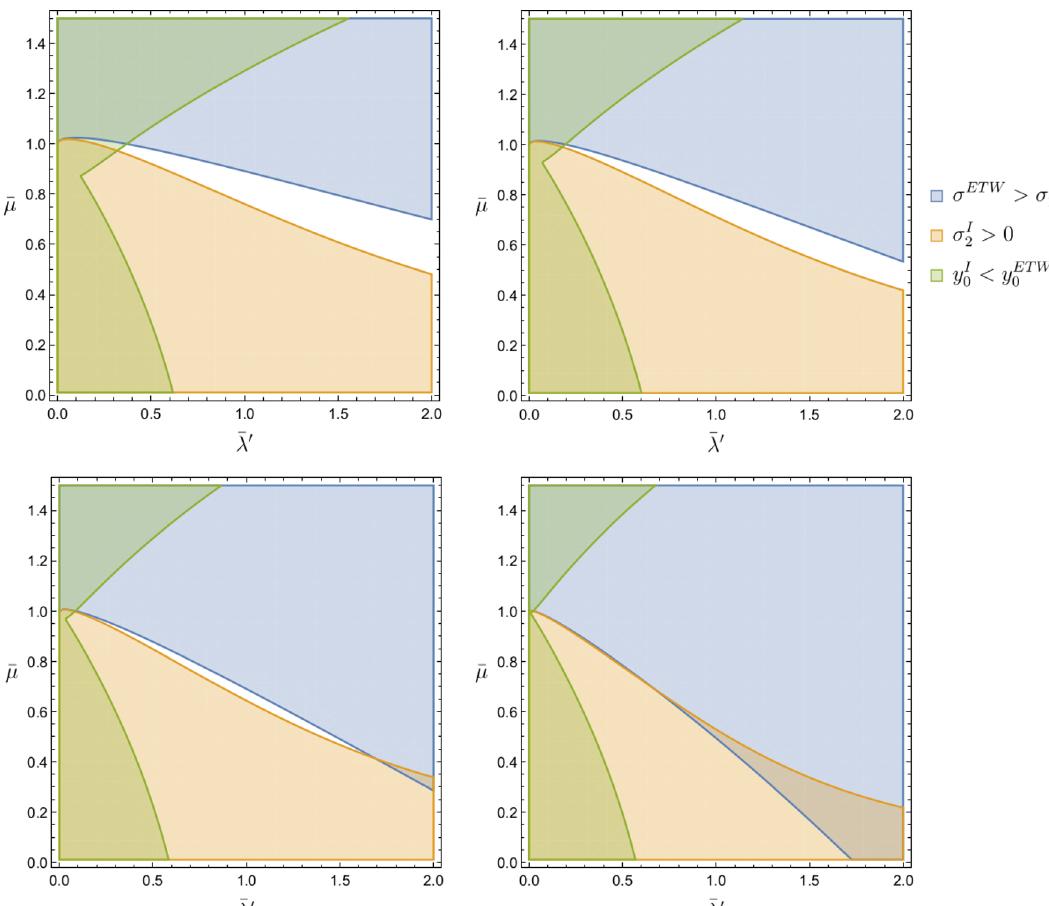
Figure 5 . Plots of the regions in the parameter space (¯ λ 0 , ¯ µ ) with σ ETW > σ I with d = 4 , ¯ T = ¯ T ∗ ≈ 0 . 7977 . Reading from top left to bottom right: x = 0 . 08 , 0 . 06 , 0 . 04 , 0 . 02 . At this critical value, we see that the only point where all the constraints are satisfied is ¯ λ 0 = 0 , ¯ µ = 1 , for all values of x . This corresponds to the solution with no interface brane, as ¯ κ min = ¯ κ max = 0 for ¯ λ 0 = 0 , ¯ µ = 1